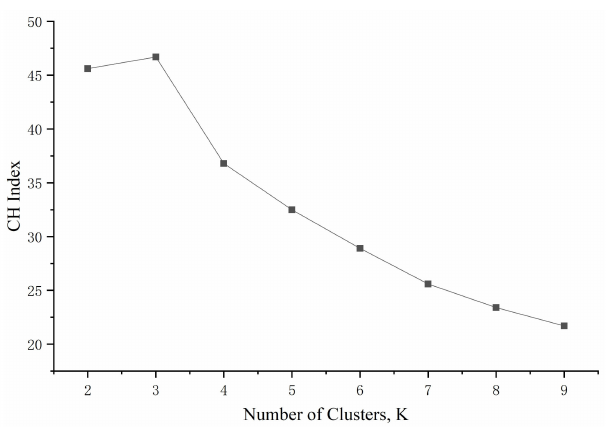
Figure 1. The number of clusters, using the Calinski–Harabasz (CH) index. Table 4. The result of the driver classification.